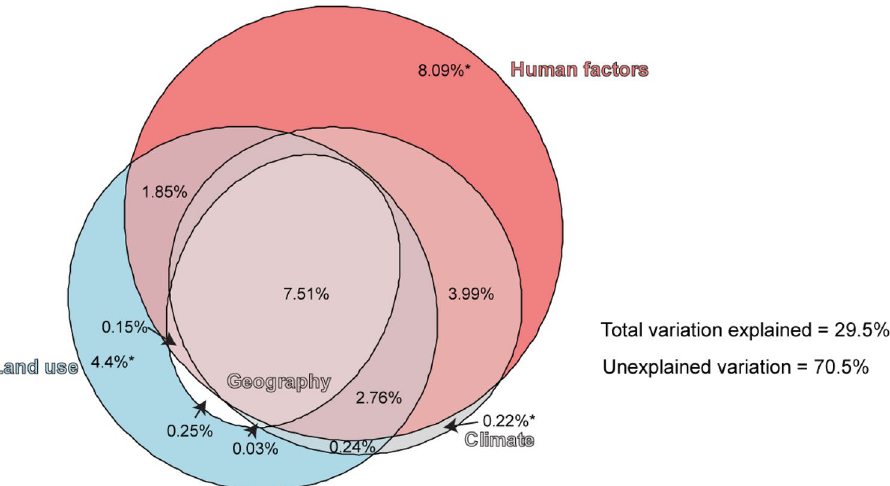
Figure 4. Area-proportional Euler-Venn graphs illustrating the partitioning of variation explanatory power on invasion degree among the main invasion drivers groups. *Marks significant unique variation explained ( P < 0.01).